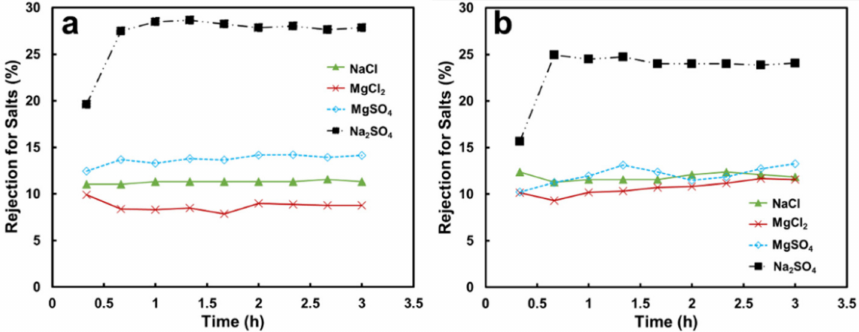
Figure 5. Time-resolved salt rejection coefficient using ( a ) non-woven/PVDF-PAA and ( b ) non- woven/PVDF-PAA-GO composite membranes. Salt solutions: 2000 ppm for NaCl and MgSO 4 , 938 ppm for MgCl 2 , and 883 ppm for Na 2 SO 4 .